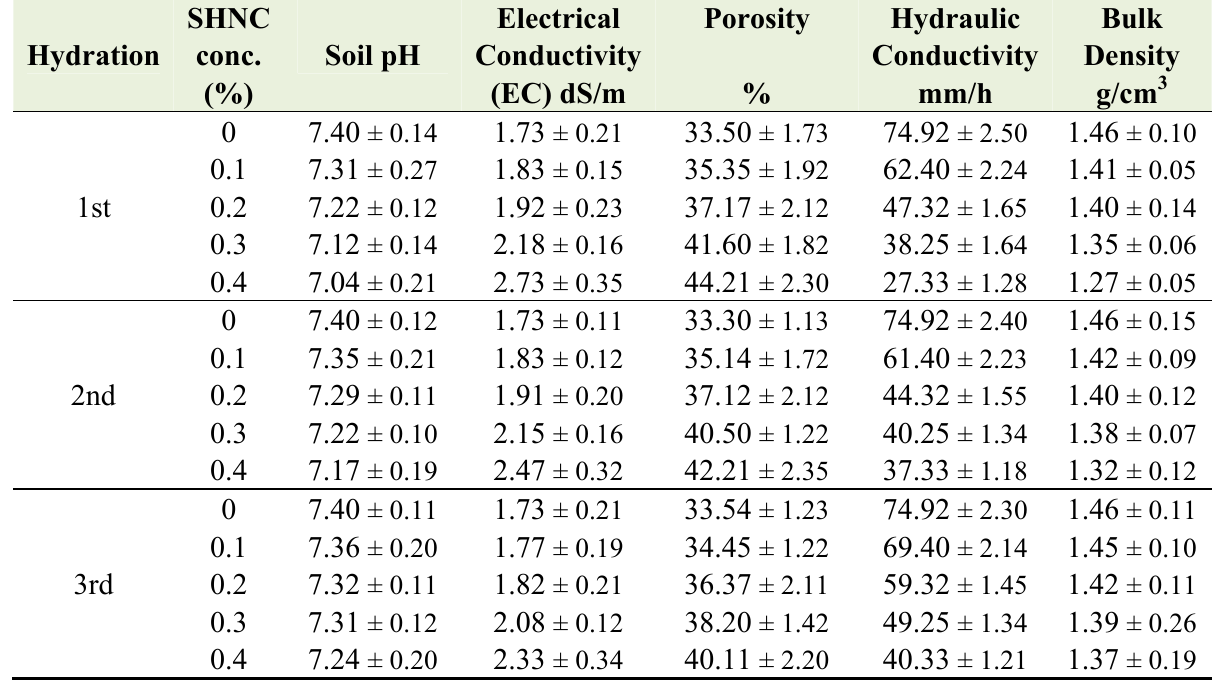
Table 1. Effect of different levels of SHNC on physical properties of sandy loam